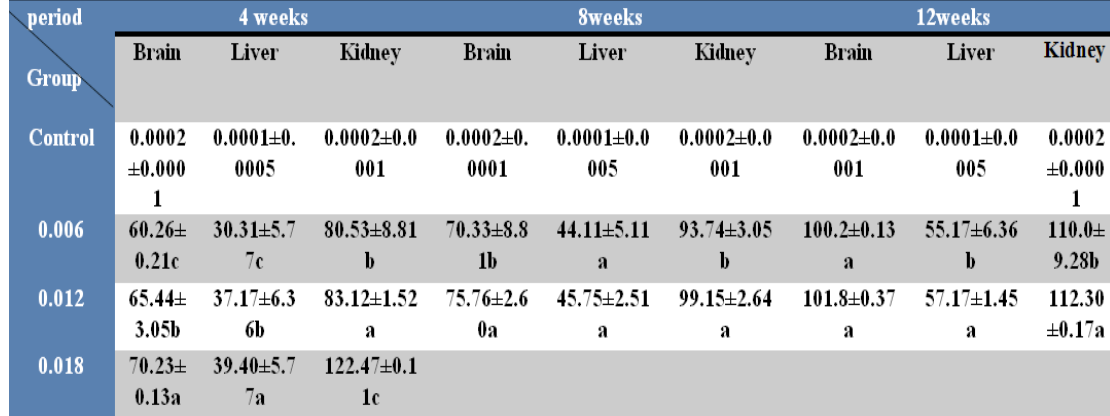
Table (2): Residual of mercuric chloride in rats organs which treated orally with compounds with doses (0.006, 0.012, 0.018 mg/kg BW) for (12 weeks). Different small letters means significant ( p <0.01) results between groups